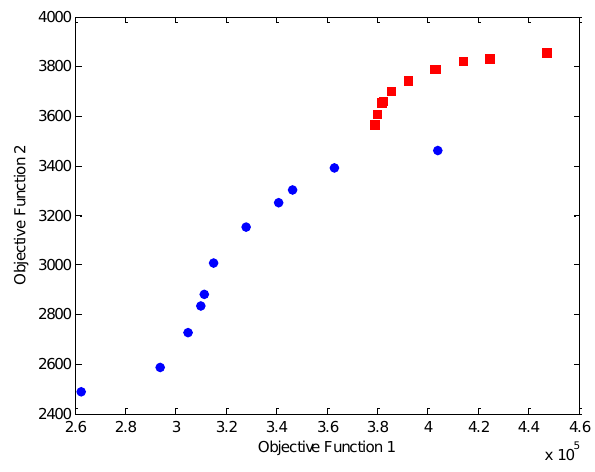
Figure 4. Pareto frontier for Scenario 1 of the example.